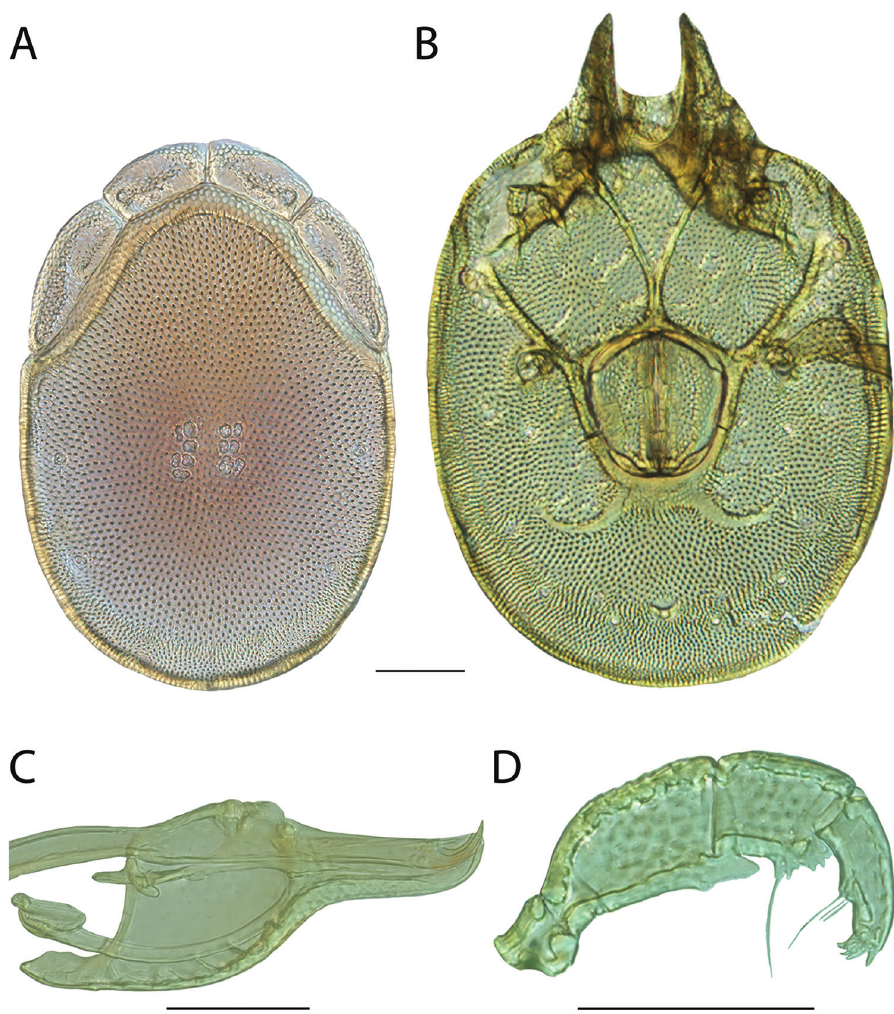
Figure 42. Torrenticola copipalpa sp. n. female: A dorsal plates B venter (legs removed) C subcapitulum D pedipalp (setae not accurately depicted). Scale = 100